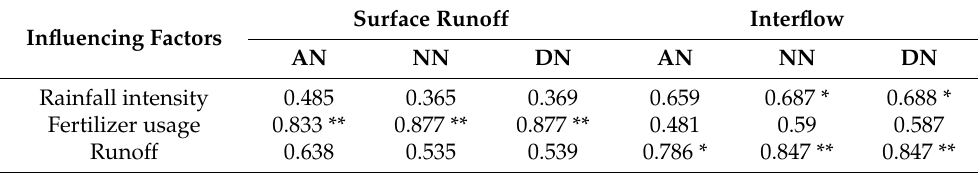
Table 5. Correlations between ammonia nitrogen (AN), nitrate nitrogen (NN) and dissolved nitrogen (DN) with rainfall intensity, fertilizer usage and runoff in surface runoff and interflow.